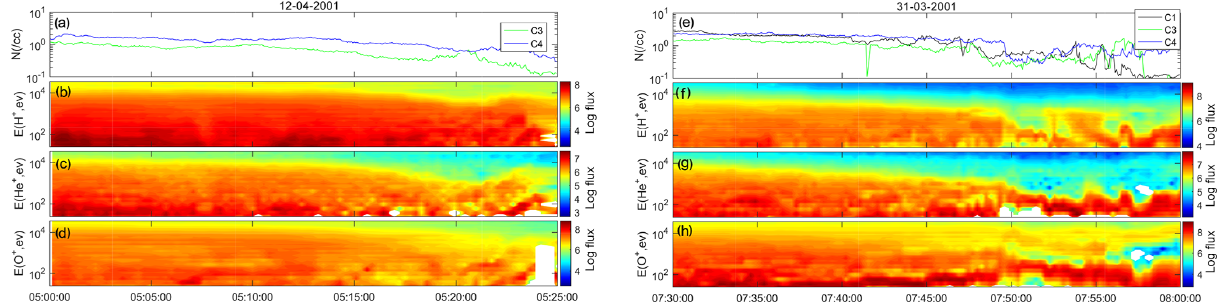
Figure 1. Cluster CIS data for 12 April 2001 (left) and 31 March 2001 (right) event. (a, e) The proton density variation for three satellites: C1 (black), C3 (green), and C4 (blue). (b–d, f–h) H + , He + , and O + energy–time spectrograms in particle flux units (ionscm − 2 sr − 1 s − 1 keV − 1 ) from